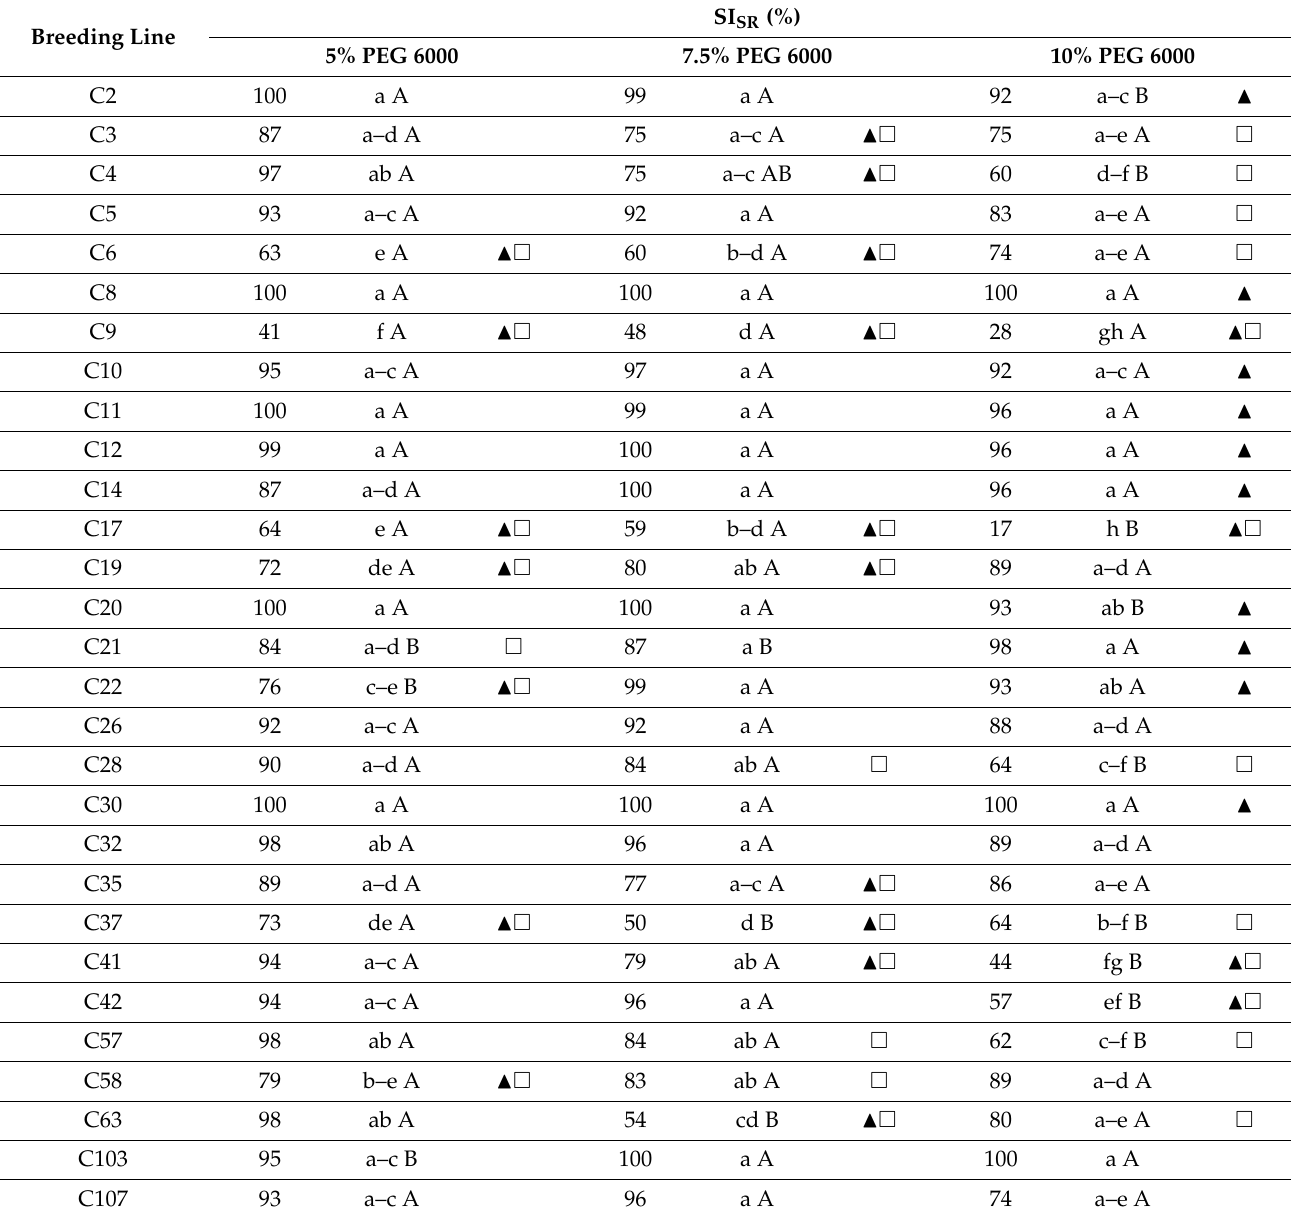
Table 2. Survival rate SI (SI SR ) values of potato genotypes under osmotic stress induced by PEG 6000 added to the medium at levels of 5%, 7.5% and